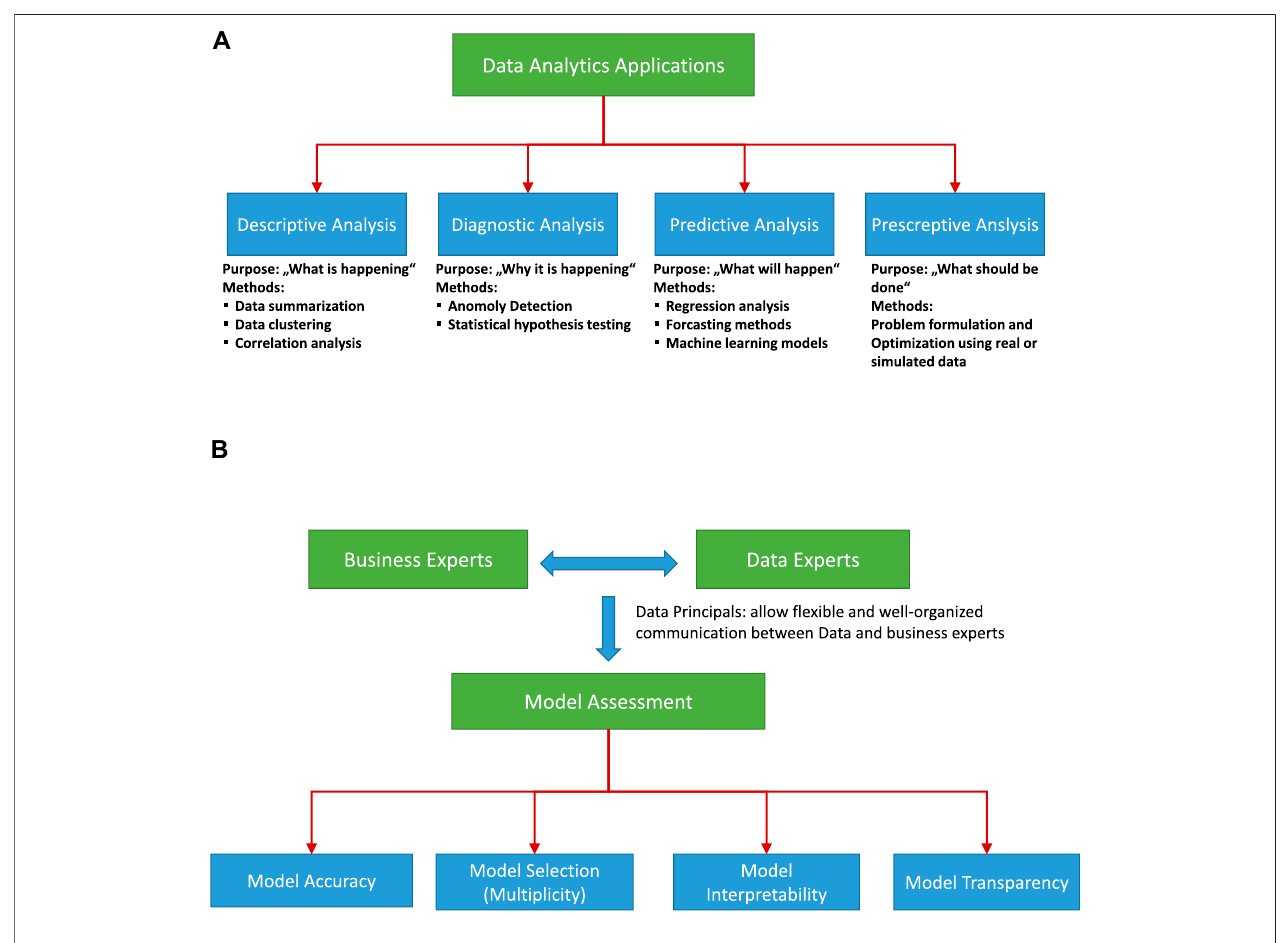
FIGURE 5 | (A) Components of data analytics problems. (B) Model